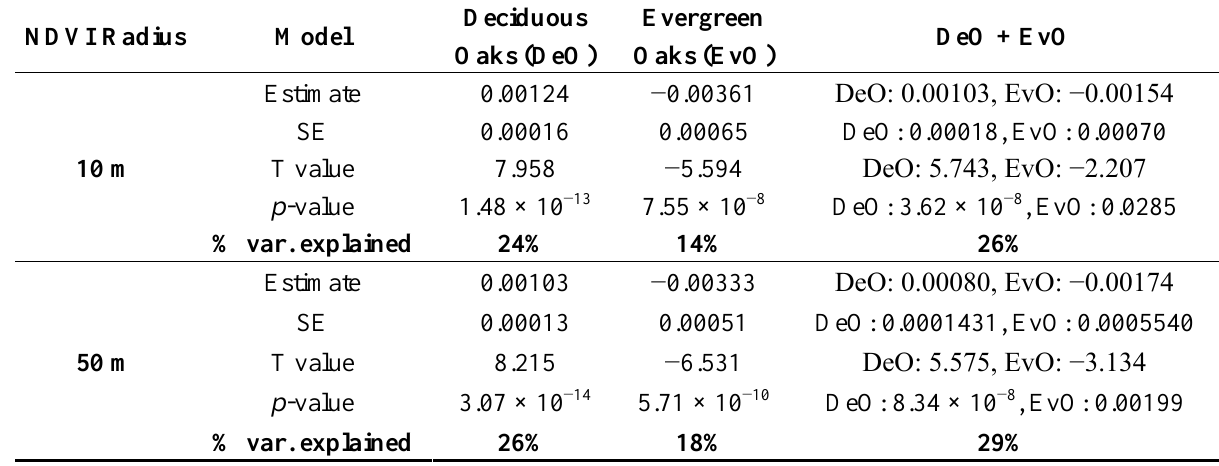
Table 2. Effect of the number of deciduous oaks (DeO), evergreen Oaks (EvO) and DeO + EvO on pixel-based summer NDVI in a 10 m and 50 m radius around the nestbox (image acquisition: 17 June